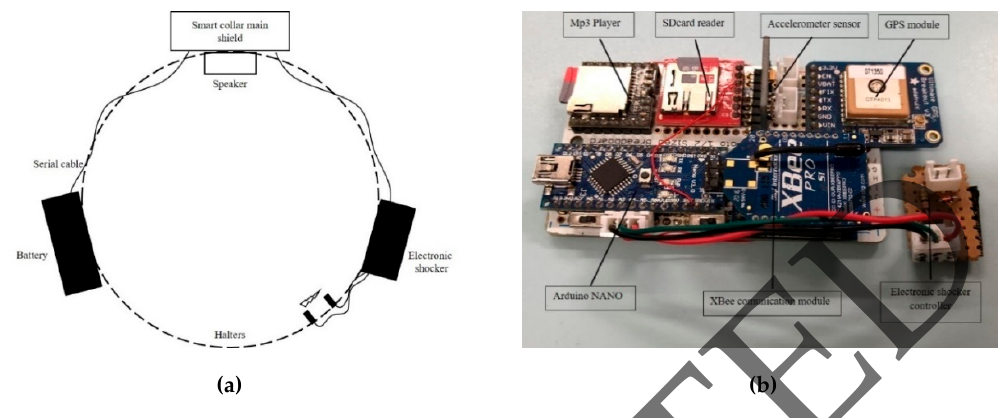
Figure 2. Virtual Fence Smart Collar: (a) The main components of a collar, consisting of a speaker (3w), battery, electrical shocker, halters, and main shield; (b) the components of the smart collar are an Arduino NANO, XBee communication module, electrical shocker controller, GPS module, accelerometer sensor, SD card reader, and mp3 player with 8GB memory card.